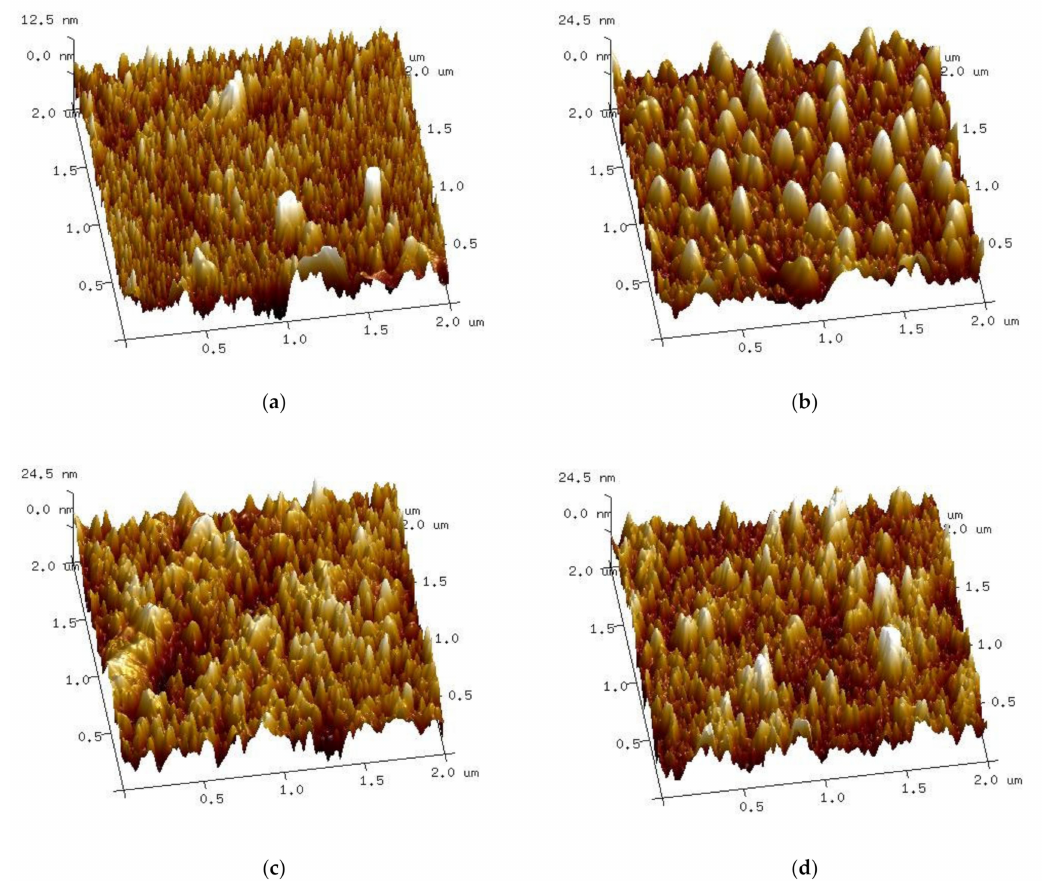
Figure 8. Atomic force microscopy 3D surface micrographs of samples ( a ) S2-Si-130, ( b ) S2-Si-130- dose1-10, ( c ) S2-Si-130-dose2-10, ( d )